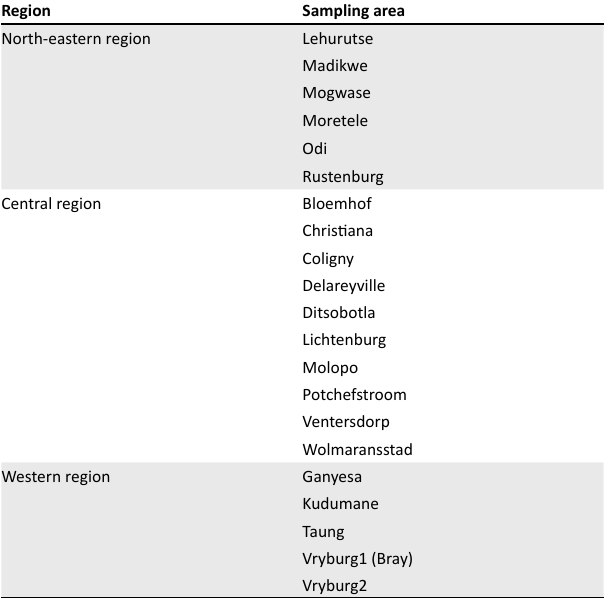
TABLE 1: Sampling areas in three regions of the North West province, South Africa.